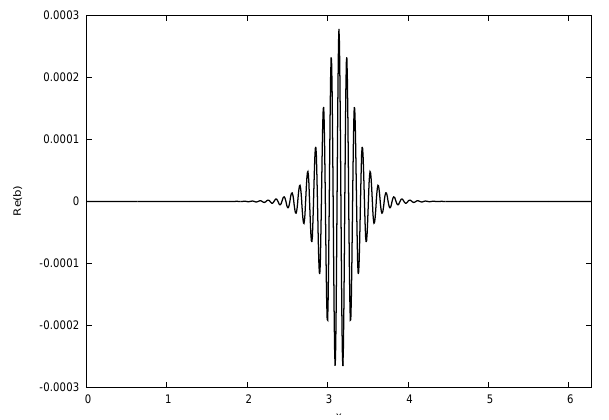
Figure 1. Real part of b ( x ) with V = 1 / 16 and Ω = 4 . 01.